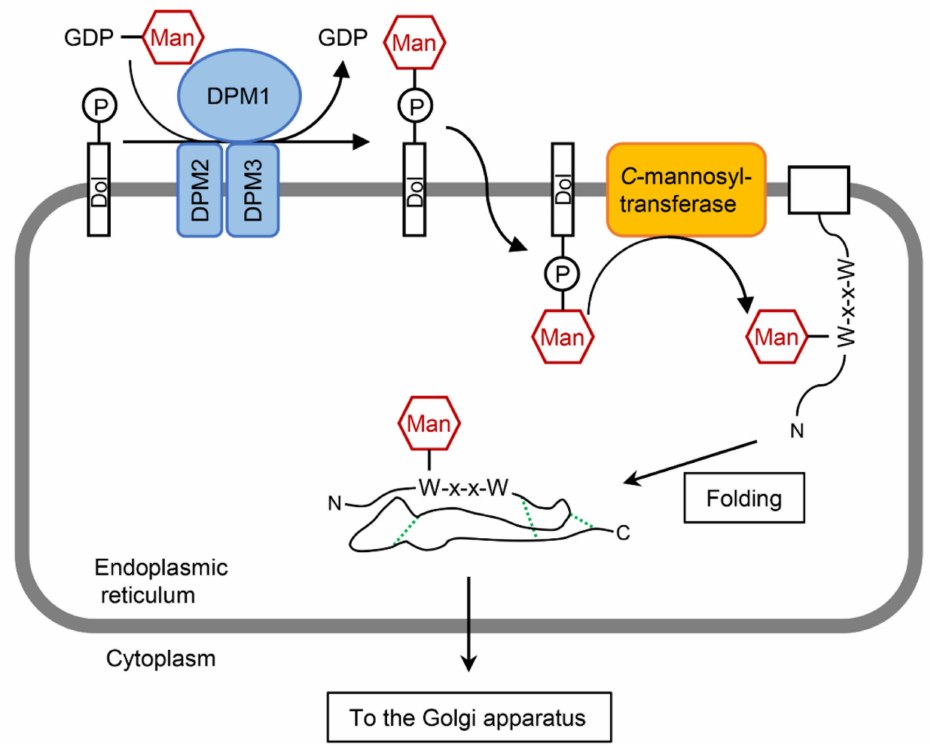
Figure 5. Biosynthetic pathway of C -mannosylated proteins in the endoplasmic reticulum (ER). The dolichyl-P-mannose (Dol-P-Man) synthase complex consists of DPM1, 2, and 3. Dol-P-Man is synthesized on the cytosolic face of the ER from Dol-P and GDP-Man, and flips into the ER lumen. The C -mannosyltransferase (i.e., DPY19L1 and DPY19L3) transfers an α -mannose to Trp in the W-x-x-W motif of the target proteins. C -Mannosylation promotes the formation of appropriate disulfide bonds and secretion of the substrate proteins. Man,